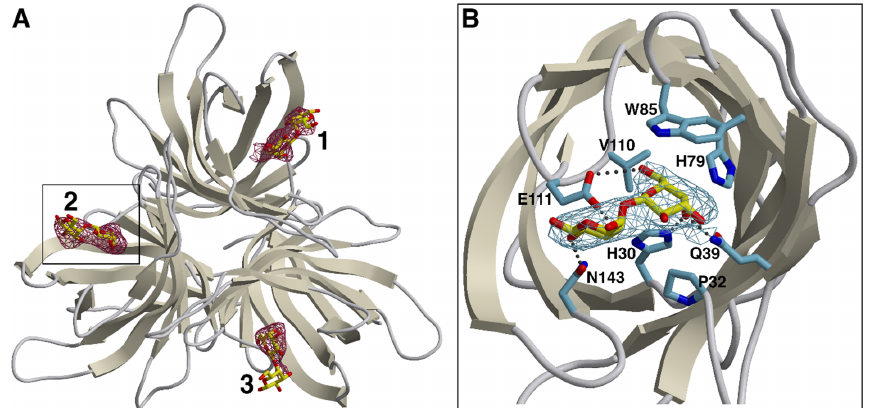
Figure 2. Binding of galactobiose to the Os JAC1 DIR domain. ( A ) Simulated-annealing omit map verifying the presence of the ligand. Following removal of the three galactobiose instances from the coordinate file, the model was subjected to an additional refinement run including simulated annealing (starting temperature 3000 K). The resulting difference density (dark red, mF o -DF c synthesis) is contoured at 2.5 RMSD in the proposed carbohydrate binding sites (labeled 1, 2, and 3 for protein chains A, B, and C, respectively). The DIR trimer (ribbons) and the galactobiose molecules (stick models, carbon atoms in yellow) represent the deposited coordinates. ( B ) Close-up of site 2, viewed along the central axis of the respective DIR domain β -barrel (other subunits omitted for clarity). Protein side chains interacting with the galactobiose ligand via hydrogen bonds (dotted lines) or van der Waals contacts are indicated. Here, the electron density (stick representation, carbon in light blue) corresponds to the 2mF o -DF c map (blue) obtained for the complete model. The figure was created using POVScript+ [42] and Raster3D [43], using secondary structure assignments generated by DSSP